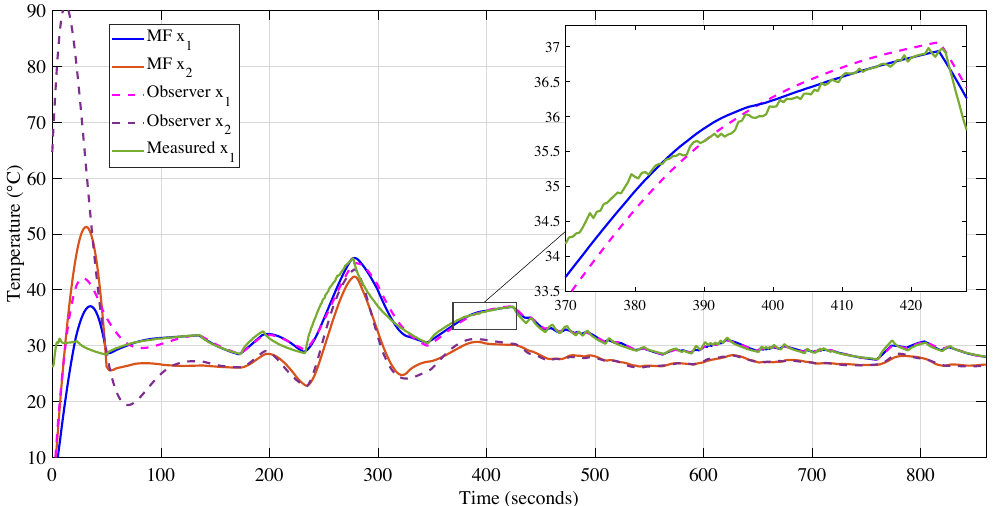
Figure 11: Measured vs. estimated temperature inside the heating chamber using the modulating function and simple